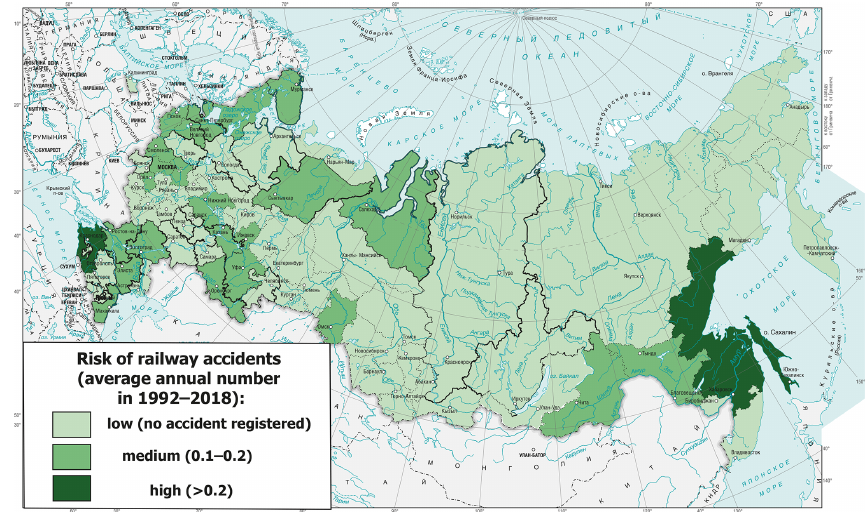
Figure 5. Risk of railway accidents and traffic disruptions triggered by natural hazards in the RF (base map © DIK – Publishing House: Design. Information.